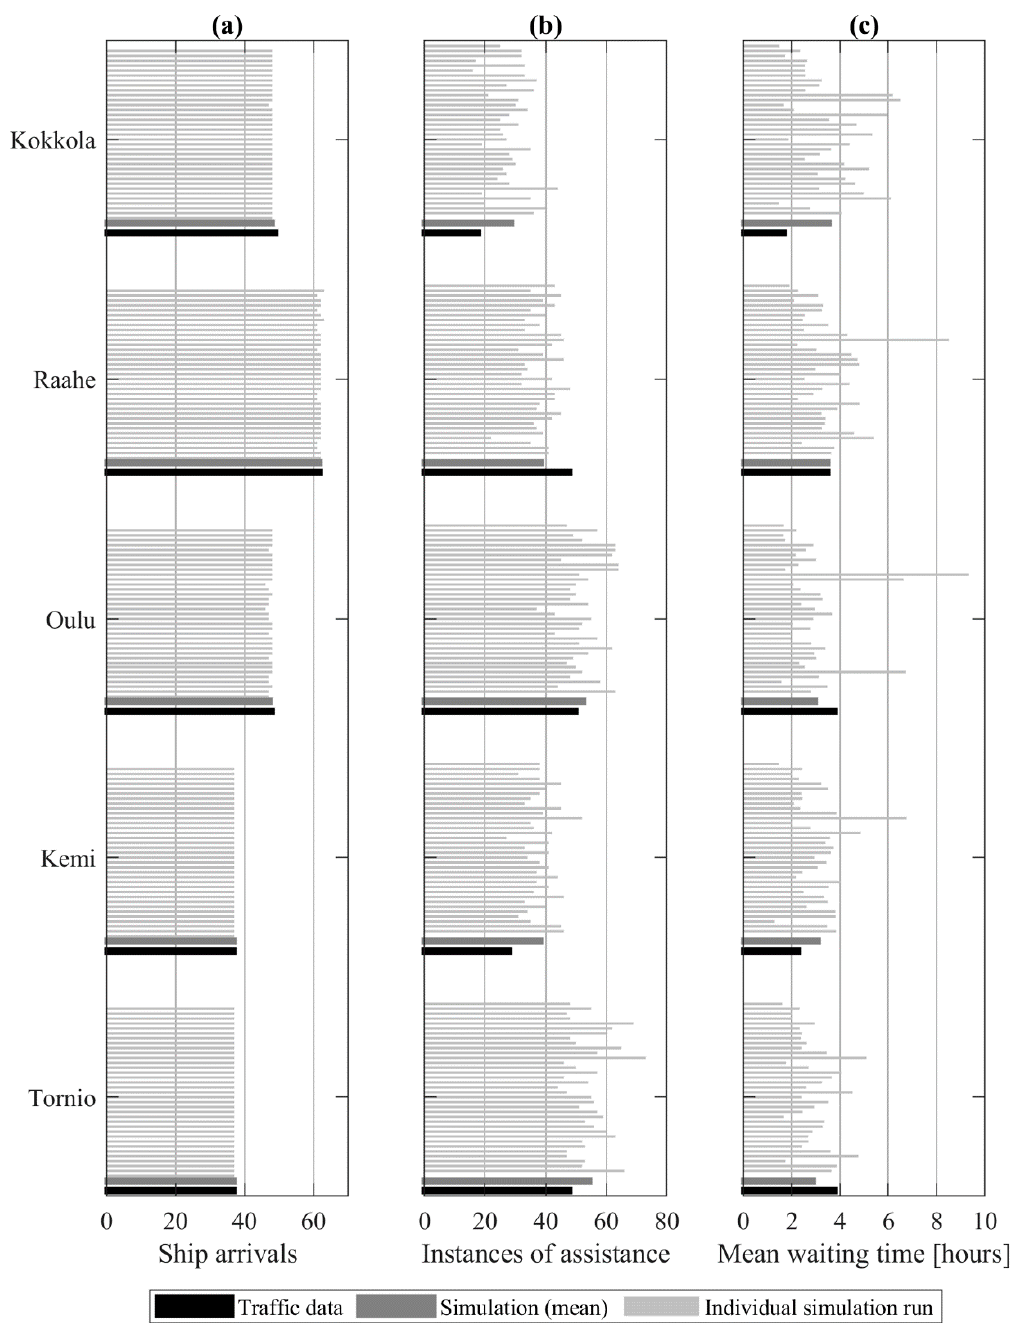
Figure 7. Real-world vs. simulated port-specific number of ship arrivals ( a ), instances of IB assistance ( b ), and mean IB waiting times ( c ). The traffic data indicate the real-world performance of the system during the considered period. The corresponding simulated performance values are presented both in terms of the mean values of 35 independent simulation runs, and in terms of the outcome of each of those individual simulation runs. The outcomes of the individual simulation runs demonstrate the variability of the simulation output.